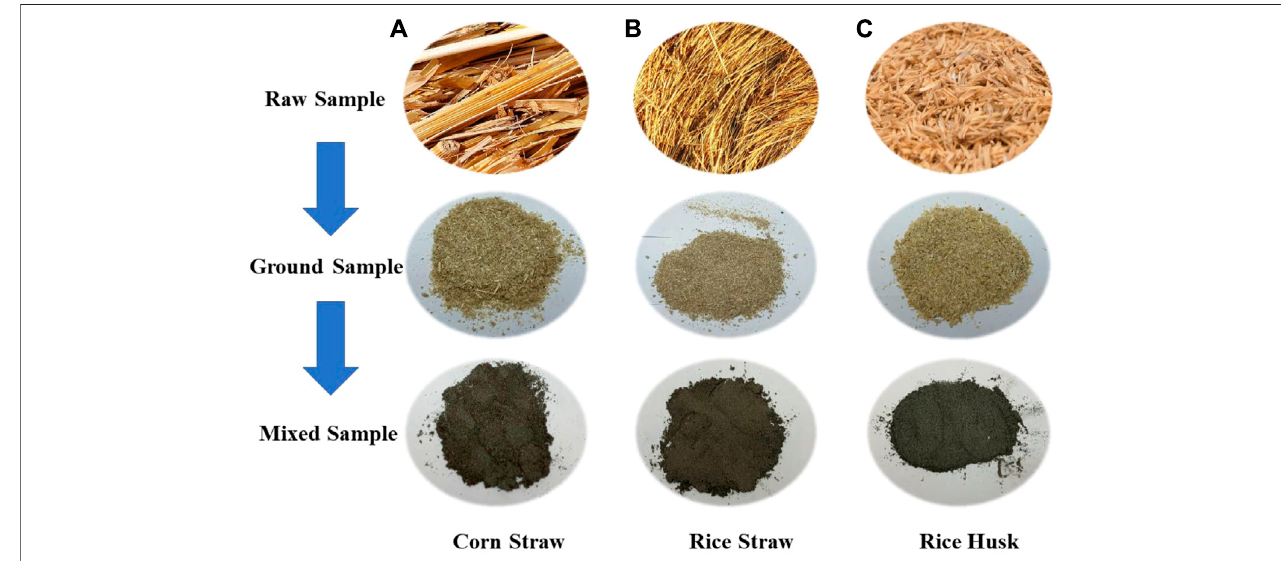
FIGURE 1 | Pictures of raw, ground, and mixed samples.